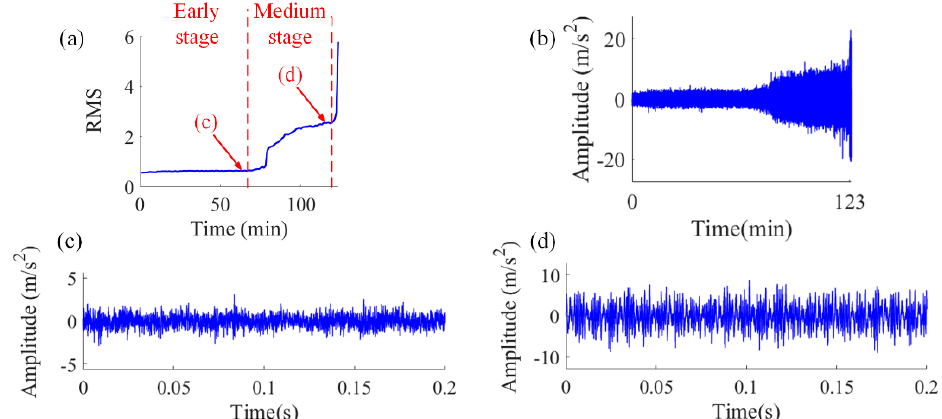
Figure 9. ( a ) Distribution of RMS values, ( b ) vibration waveform, fault signals in ( c ) early stage and ( d ) medium stage.